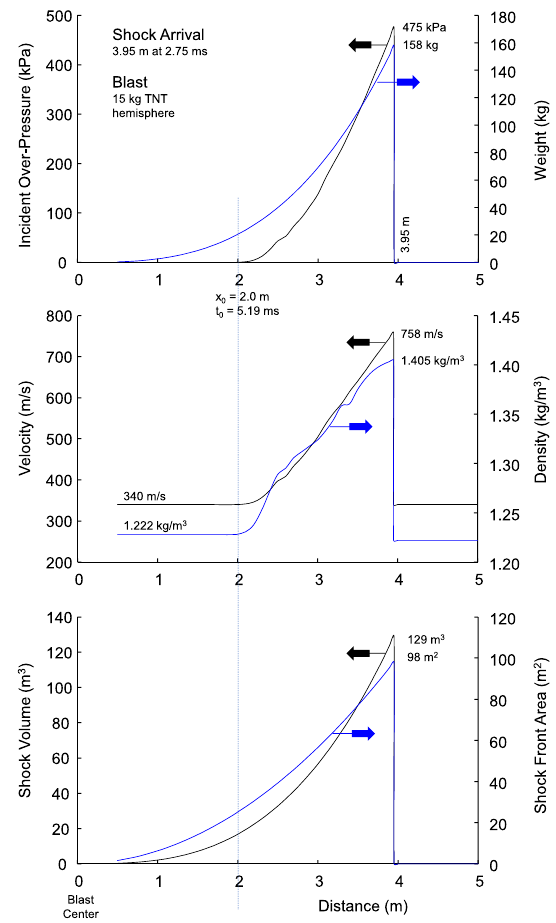
Figure 8. Shock wave characteristics for 3.95 m stand-off distance with 15 kg hemispherical